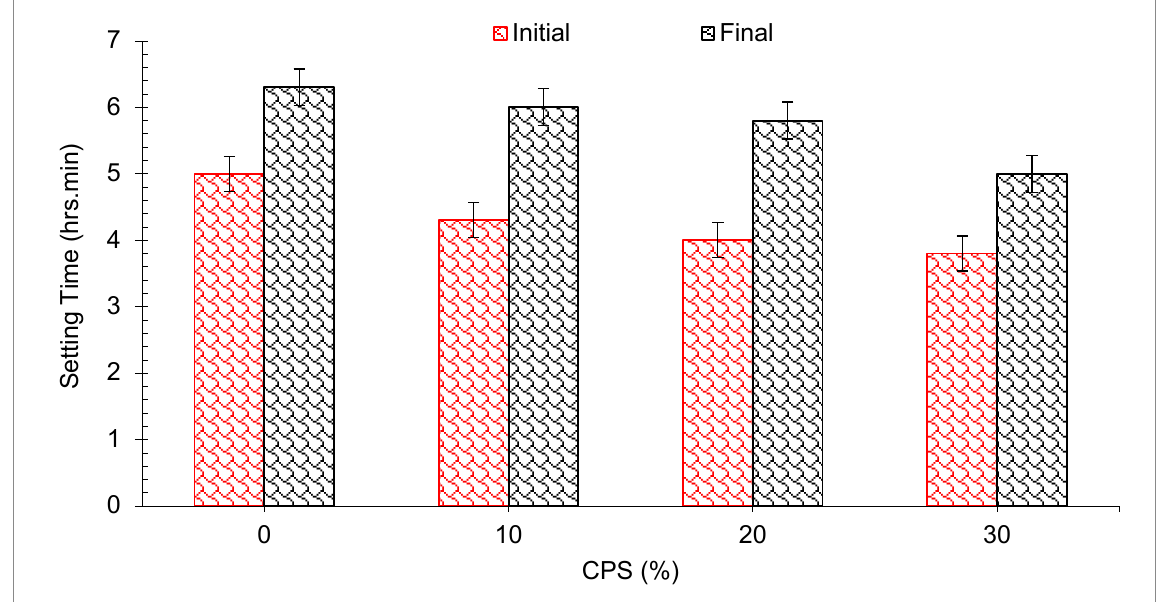
Figure 6. Setting time of mortar with CPS [64].